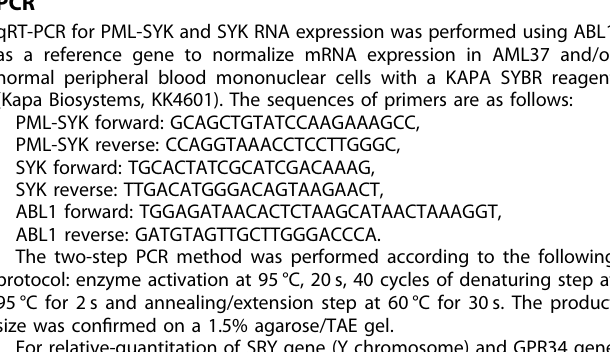
Fig. 3 Long-term evaluation of disease and the impact of treatment in stem cell and progenitor compartments during administration of PU-H71. a Evaluation of activated intracellular signaling in AML CD34 + progenitor cells (top) and CD34 + CD38-CD123 + leukemic stem cells (bottom) at day 5 and 11 during PU-H71 therapy. Red shows fl orescence minus one (FMO) control. b Clinical assessment of the percentage of blasts in bone marrow at baseline and on day 43 after 10 does of PU-H71. Bone marrow aspirate showed <5% blasts with con fi rming complete remission (CR). c The clinical course of the patient WCM254 from day 60 to day 589. Blue circles, absolute leukocyte counts; red triangles blast counts in PB. PU-H71 administration, green square. Gray shaded area, normal range of leukocyte counts. The patient remains in clinical remission under continuous treatment of PU-H71 for over 600 days. (Inset) Pathological evaluation of bone marrow biopsy at day 190. H&E staining of bone marrow shows slightly hypercellular marrow (left panel) but without evidence of myeloblasts by cytomorphology and immunohistochemistry for CD34 and c-KIT (center and right panels). d Evaluation of intracellular signaling in leukemic stem cells (LSCs, CD34 + CD38-CD123 + ) and hematopoietic stem cells (HSCs, CD34 + CD38-CD123-) in bone marrow aspirates at baseline (top row) and on day 190 (bottom row). LSC population (CD34 + CD38-CD123 + ) at baseline showing hyperactivated signaling was replaced with CD34 + CD38-CD123- hematopoietic stem cells (HSCs) populations with downregulated signaling on day 190. e Epichaperome abundance evaluated by fl ow cytometry on day 190 and day 197. Epichaperome increase in cells from both BM and PB was detected on day 190. Rapid and signi fi cant decrease of epichaperome abundance on day 197 after one dose of PU-H71 suggested target engagement. ** p = 0.0042,